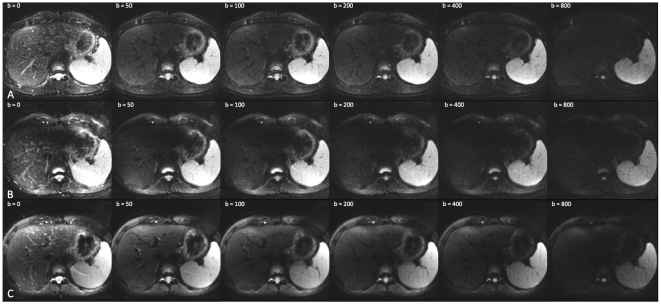
Representative ADC-images.Representative ADC-images positioned at the same level of the left lobe of the liver from the same volunteer in all three scanners (A–C). Inhomogeneous signal is seen particularly in the left lobe of the liver with the first generation 3 T scanner (B).